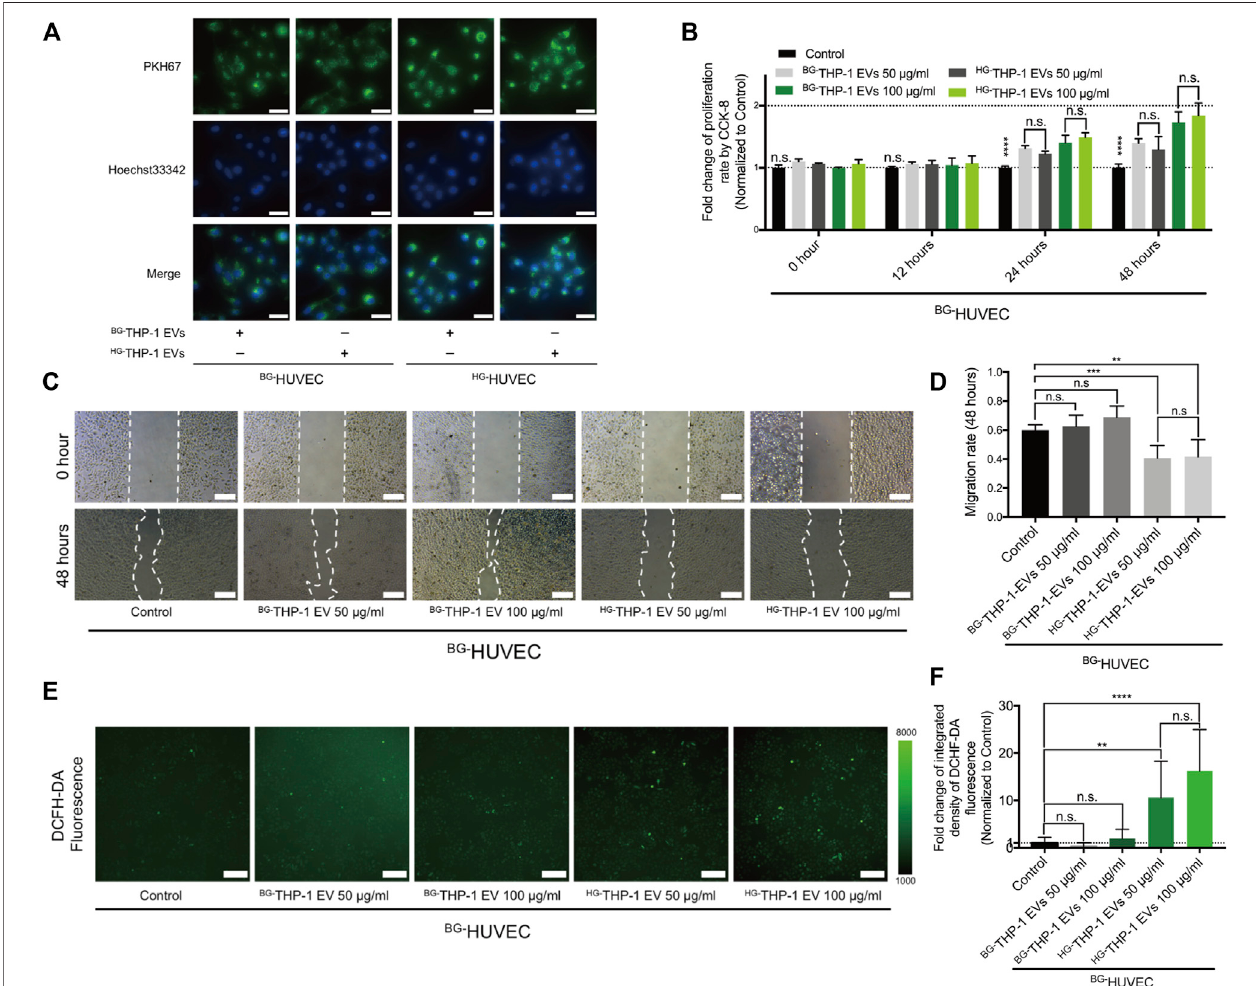
FIGURE 2 | The regulatory effects of THP-1 EVs on HUVECs (A) The uptake of PKH67 (green fl uorescent dye) -labelled THP-1 EVs (50 μ g/ml) by HUVECs. Scale bar = 40 μ m (B) The impact of THP-1 EVs on HUVECs proliferative ability (C) The impact of THP-1 EVs on HUVECs migration. Scale bar = 200 μ m (D) Quantitative analysis of migration rate (E) The impact of THP-1 EVs on the production of ROS in HUVECs detected by DCFH-DA fl uorescence. Scale bar = 200 μ m (F) Quantitative analysisofDCFH-DA fl uorescence.Dataarepresentedasmean±SDandanalyzedusingtheANOVA,n.snotsigni fi cant,* p < 0.05,** p < 0.01,*** p < 0.001,**** p < 0.0001. n =